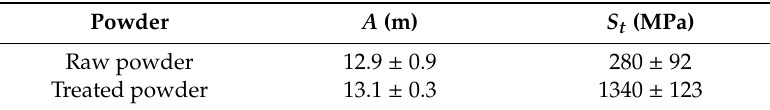
Figure 10. Typical load-displacement curves of ( a ) the raw powder and ( b ) the plasma treated powder with the pictures of tested WC–12%Co particle after compression test. Table 2. Diameter and tensile strength achieved in the compression test.